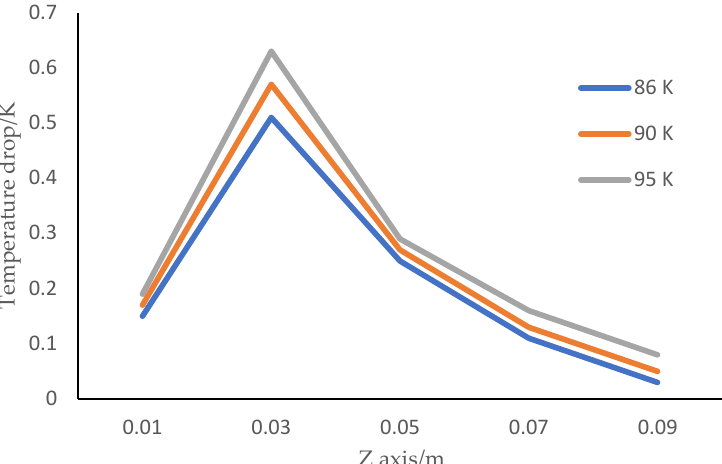
Figure 10. Temperature difference distribution of three liquid oxygen temperatures in the Zwart- modified cavitation model.